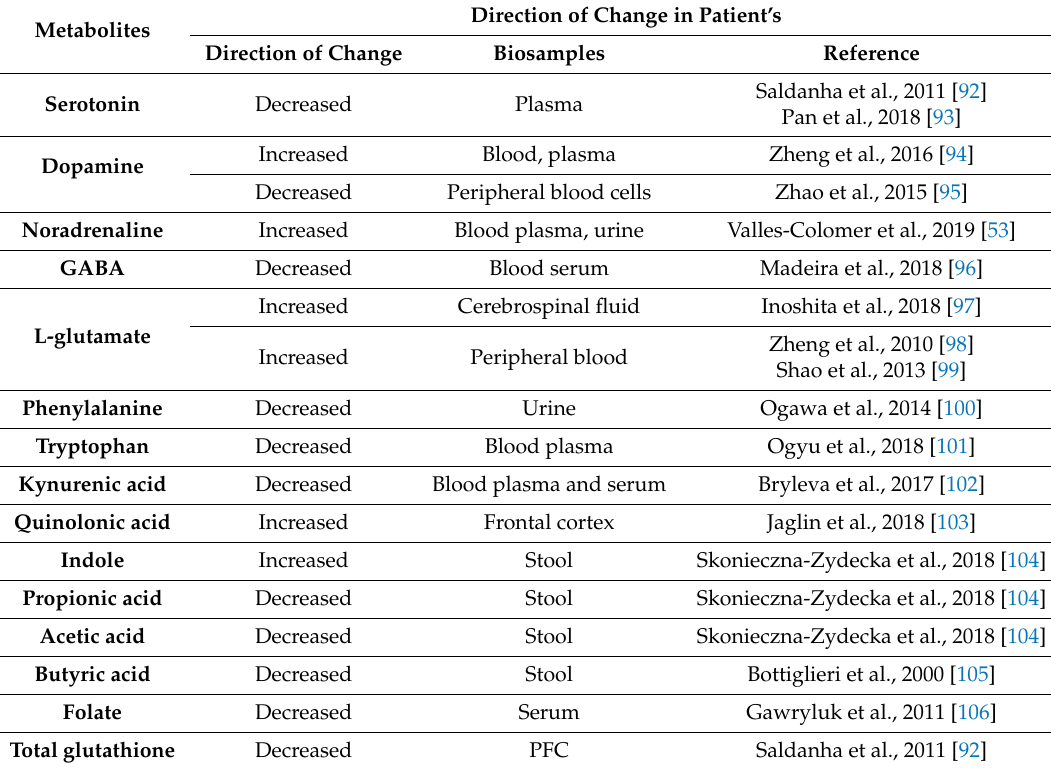
Table 2. Altered metabolites in patients with